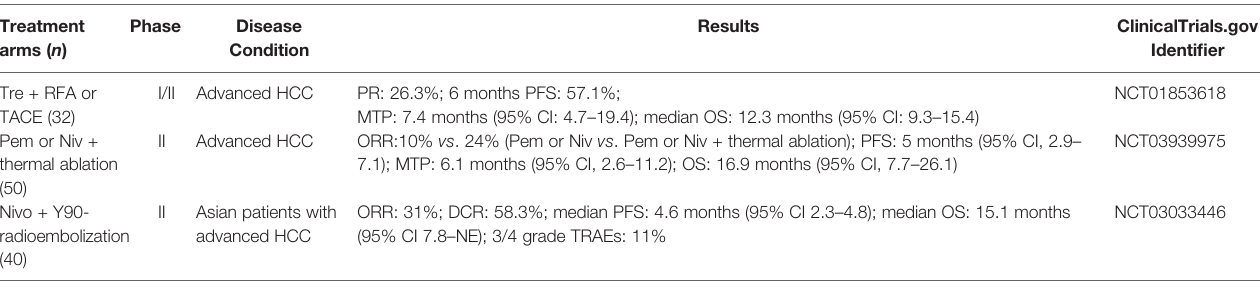
TABLE 4 | Completed clinical trials of combining immune checkpoint inhibitors with locoregional therapies in